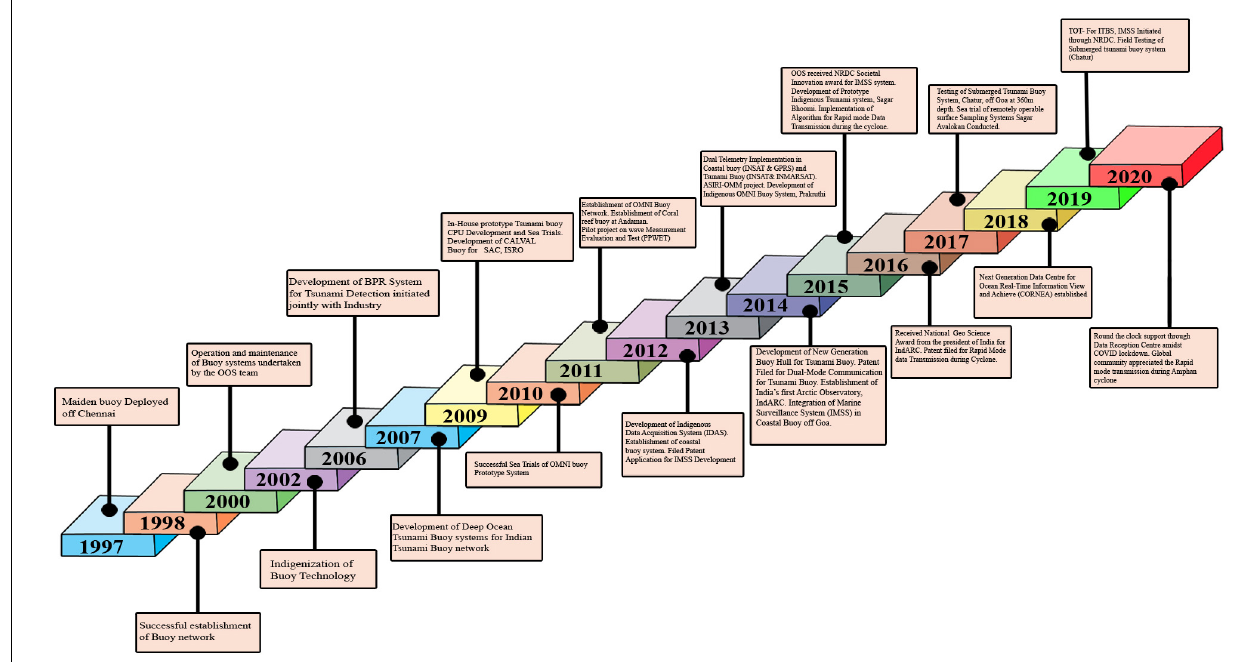
FIGURE 3 | The major milestones of the Indian moored buoy